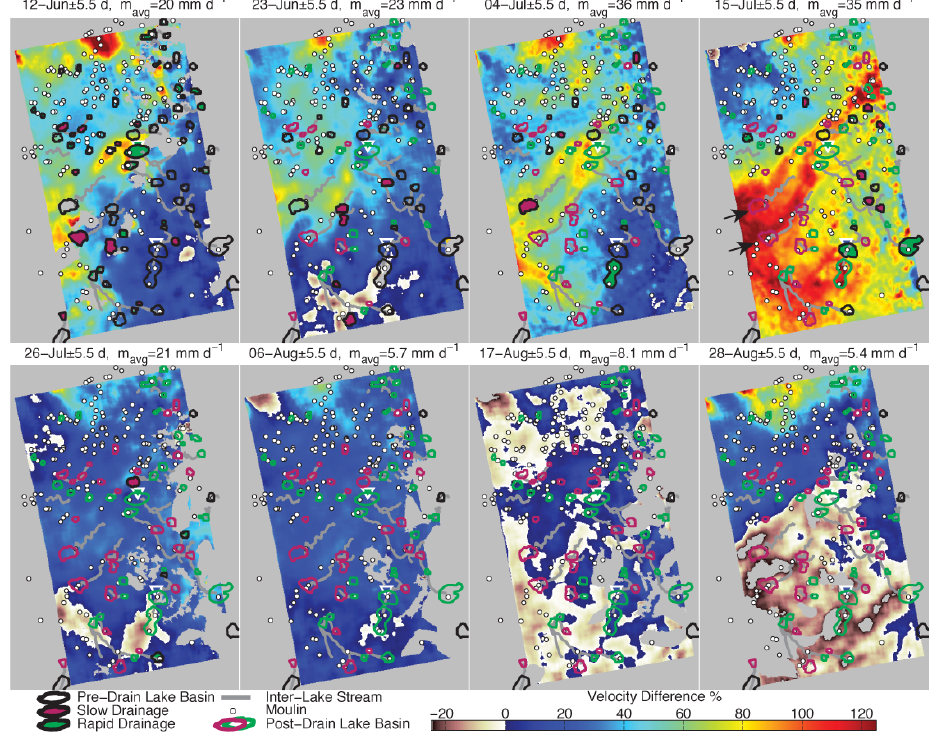
Fig. 3. Increase in summer 2009 flow speed relative to the winter velocity expressed as a percentage of the winter speed with gray to indicate regions of no data. The date for each panel corresponds to the central date for each 11- or 22-day interval over which velocity is determined. Also plotted are the surface features shown in Fig. 1, excluding smaller surface streams, with color coding to indicate the 11-day interval when lake drainage commenced. Prior to drainage, lakes are shown with black outlines. A solid fill indicates the period when a lake drained rapidly (green) or began draining slowly (magenta). For the periods following initial drainage, magenta outlines indicate continuing overflow to a nearby moulin. For fast draining lakes, the green outlines indicate the post-drainage period when water inflowing to the lake basin drains directly to the lake’s moulin. Triangles show the location of GPS stations with color as indicated in Fig. 1. Mean daily surface melt estimates, m avg , determined using the RACMO2 (van Angelen et al., 2012) are shown beside the corresponding date for each map. Note maximum of speedup on 15 July is located just downglacier of the major surface streams indicated by black arrows (see high-resolution version in